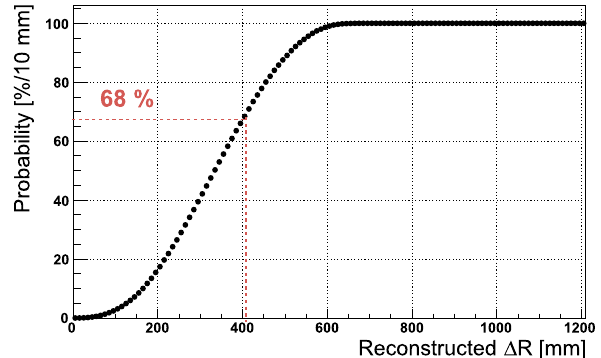
Fig. 7 Photo-electrondistributionasafunctionofenergyrangingfrom 1 to 10 MeV with 1MeV step obtained using simulated electrons gen- erated at the center of the detector